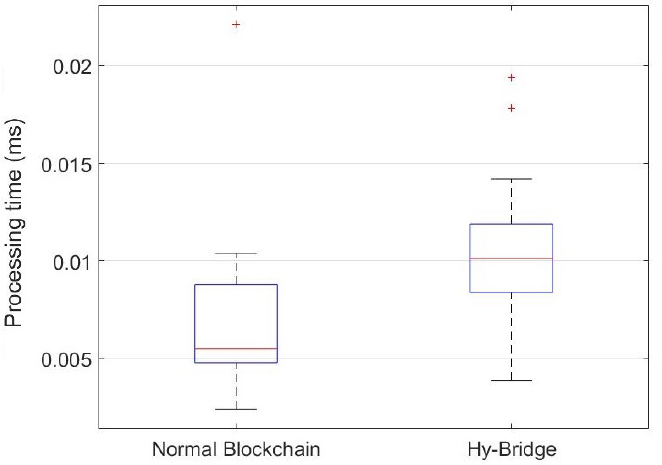
Figure 11. Processing time for block adding to the normal blockchain and Hy-Bridge based on IoT power consumption presented in Table 1.